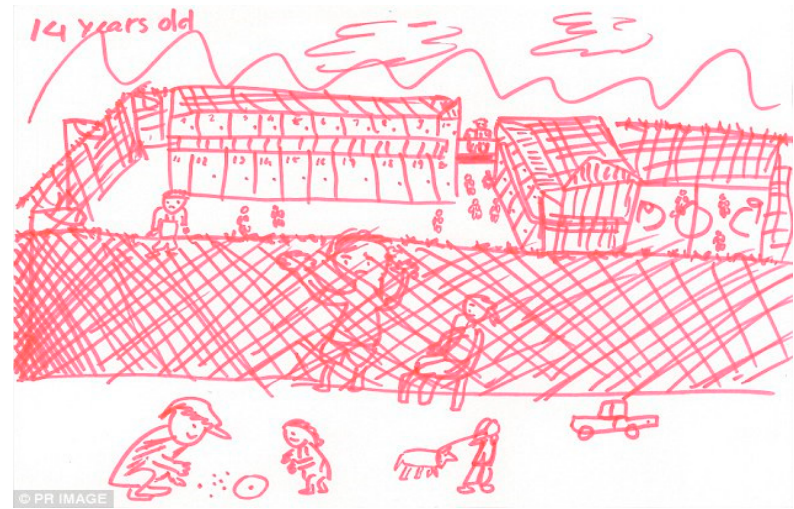
Figure 4. Drawing by secondary school-age child, gender redacted, held at Darwin Detention Center. © Australian Human Rights Commission 2014. The Forgotten Children: National Inquiry into Children in Immigration Detention 2014 .